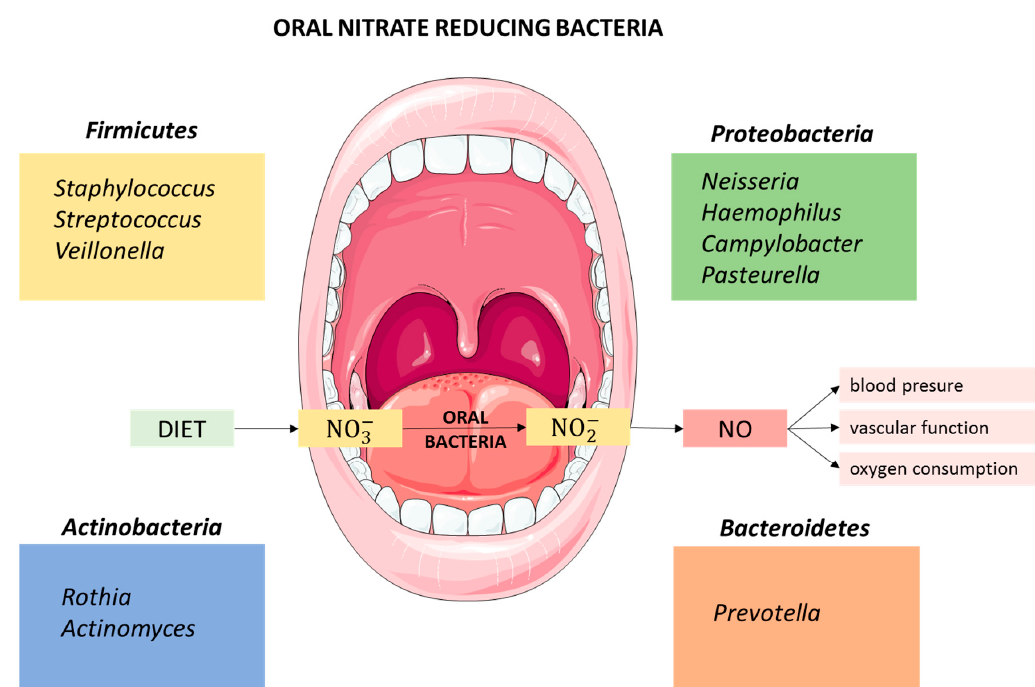
Figure 1. Relevant genera of nitrate-reducing bacteria isolated from the oral cavity. Table 1. Summary of studies identifying oral nitrate-reducing bacteria with or without nitrate